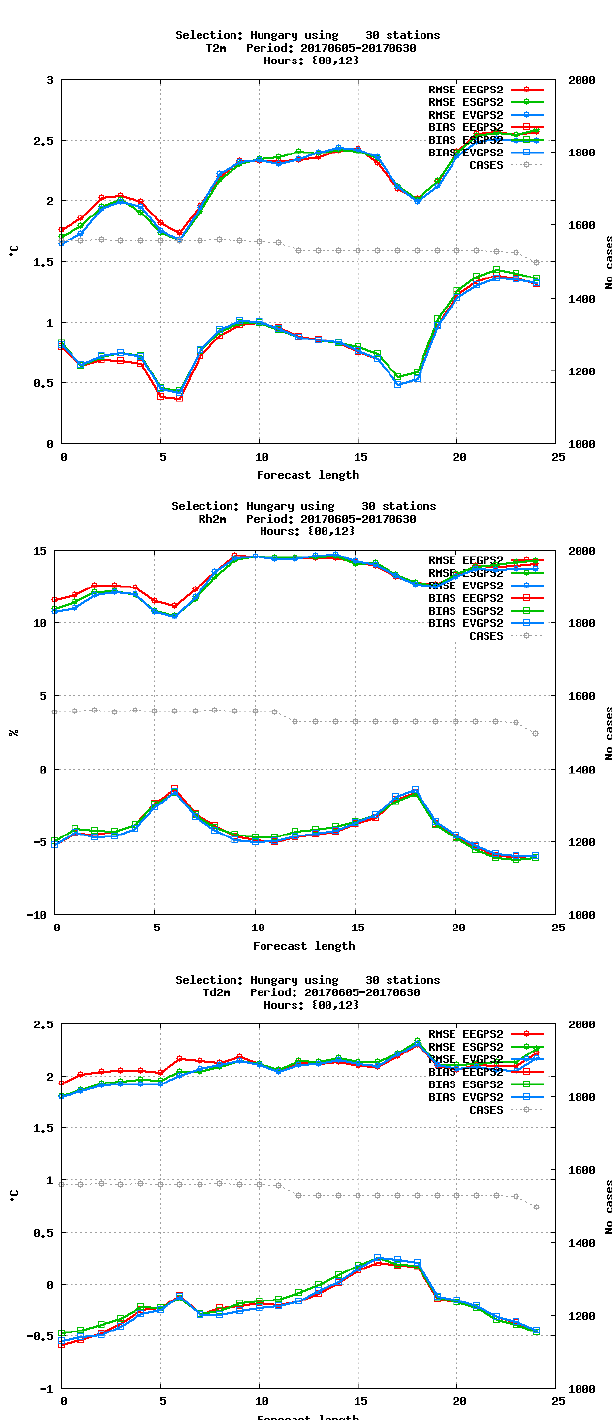
Figure 8. The RMSE and bias of screen-level temperature ( ◦ C), relative humidity (%), and dew-point temperature ( ◦ C) as a func- tion of forecast range. Scores are plotted for EEGPS2 (red), ES- GPS2 (green) and EVGPS2 (blue). Verification period between 5 and 30 June 2017. Data selection: Hungary, 30